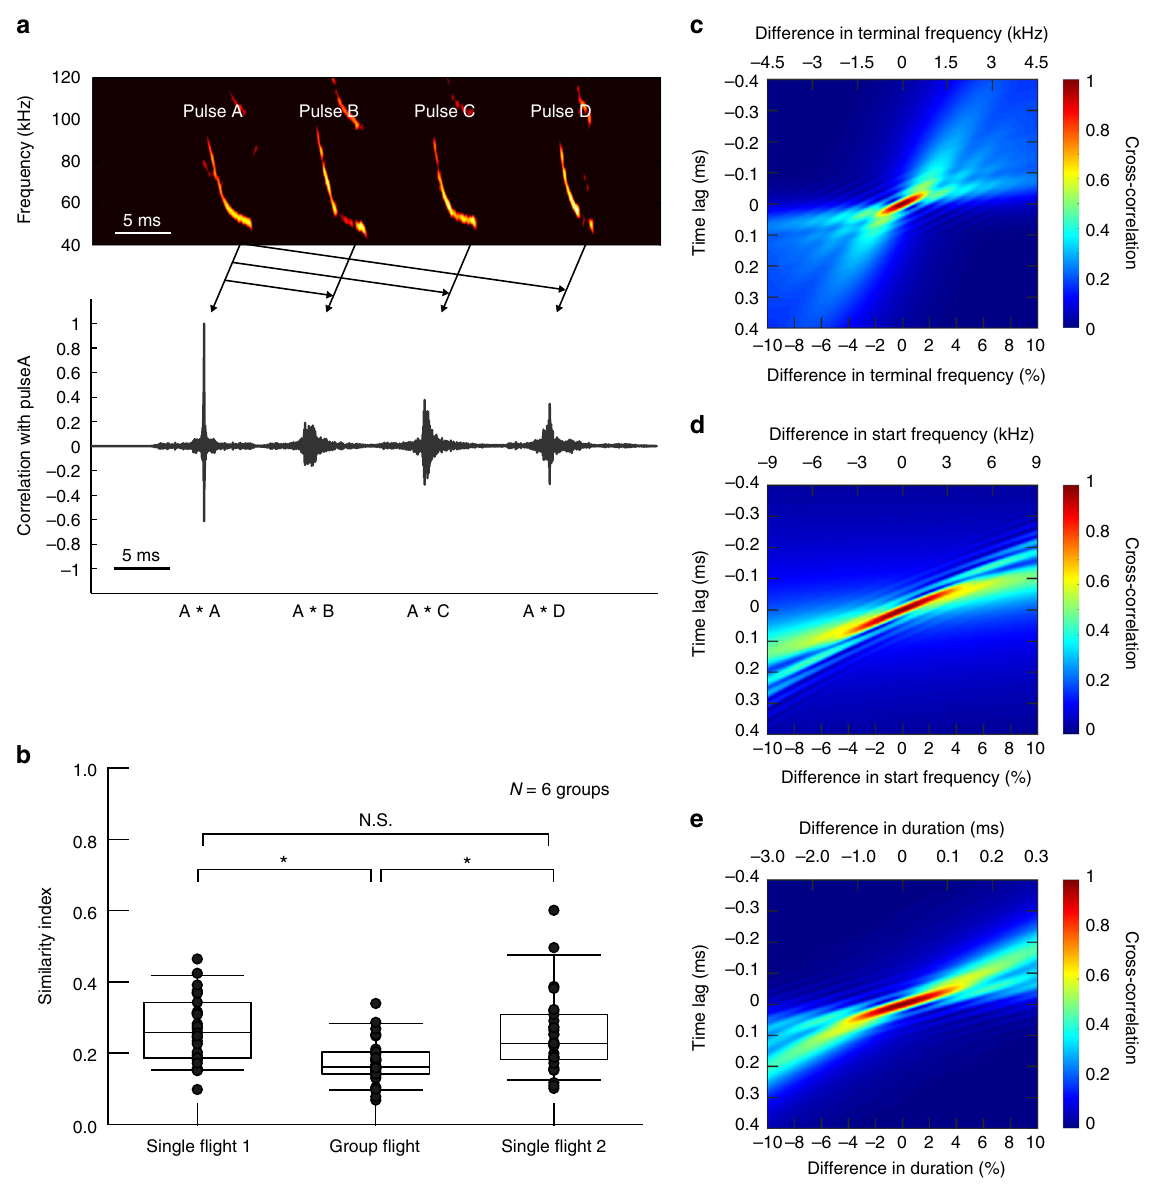
Fig. 4 Similarities between pulses among bats of the same group and the effects of changes in acoustic characteristics on the similarities between frequency-modulated signals. a Spectrograms of the pulses of four bats fl ying together (top); correlation values of pulses A, B, C, and D with pulse A (bottom). b Peak cross-correlation values normalized to the autocorrelation values. We analyzed the similarity indices of all pairs of calls between four individuals in each group. This analysis yielded 36 data points per fl ight condition (see Methods). The upper and lower bounds of the boxes show fi rst and third quartile, respectively. The horizontal bars above and below the boxes show the 10th and 90th percentiles, respectively. The peaks (similarity indices) signi fi cantly decreased in group fl ight compared with single fl ights 1 and 2 (Tukey ’ s post-hoc test, P < 0.05). c – e Changes in the dissimilarity function when the cross-correlation was calculated between the original frequency-modulated signal (90 – 45 kHz downward with a duration of 3 ms) and the manipulated signal in terms of c Fs, b terminal frequency, and e duration from − 10 to 10% respectively) during group fl ight, as well as the correlation values between pulse A and pulses A, B, C, and D normalized to the peak autocorrelation value of pulse A. The peak cross-correlation values with pulse A were 0.19 (vs. pulse B), 0.38 (vs. pulse C), and 0.34 (vs. pulse D) (Fig. 4a, bottom). We de fi ned the similarity index between two bats as the peak value of the cross-correlation of their pulses normalized to the autocorrelations of pulses of either bat (see Methods). Fig. 4b shows that the similarity indices between individuals were signi fi cantly lower in group fl ight (0.21 ± 0.07) than in single fl ight 1 (0.32 ± 0.12) or single fl ight 2 (0.29 ± 0.12) (Tukey ’ s HSD test, P < 0.05). COMMUNICATIONS BIOLOGY | (2018) 1:39 | DOI: 10.1038/s42003-018-0045-3 |